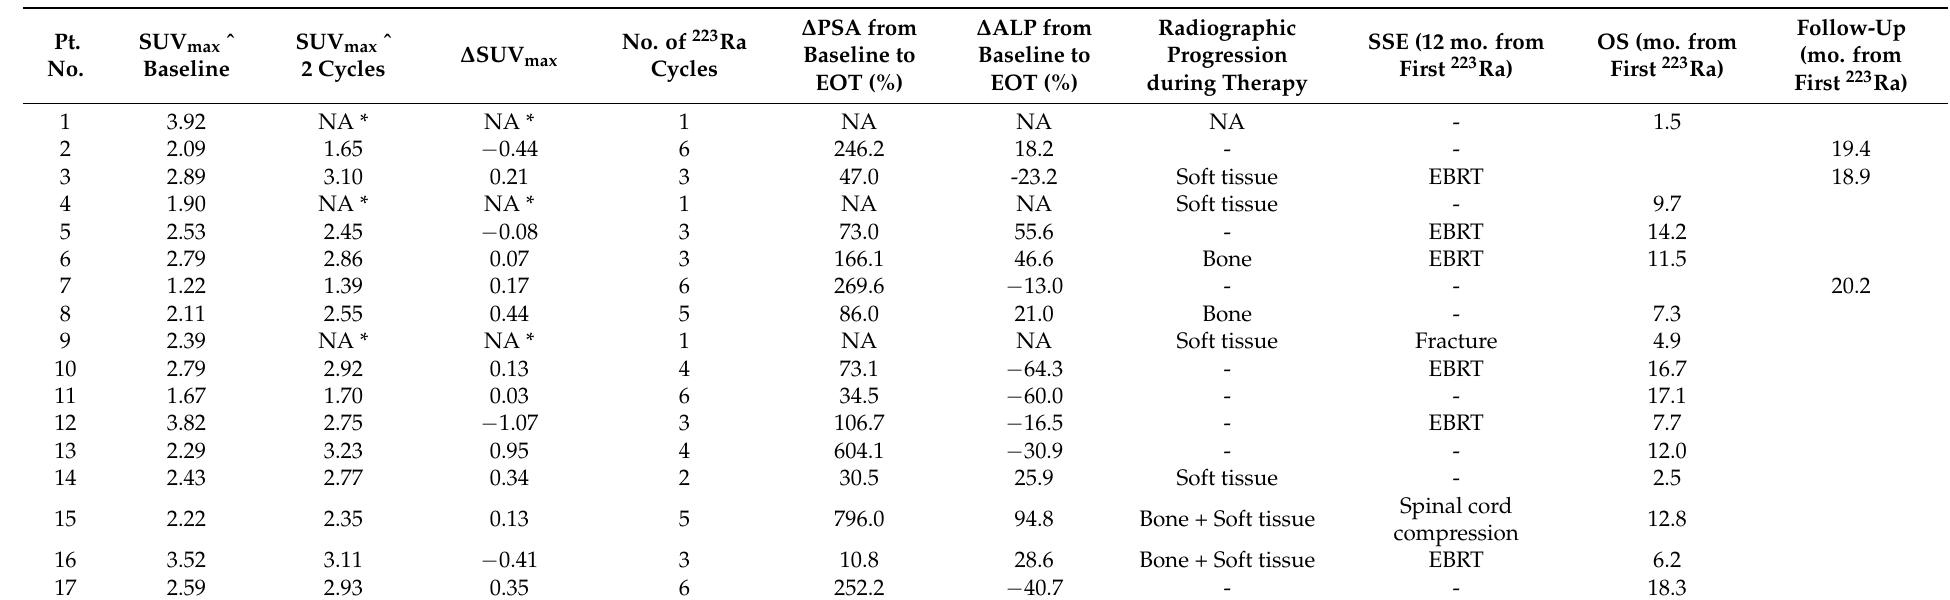
Table 2. 68 Ga-NOTA-AE105 uptake in lesions and clinical